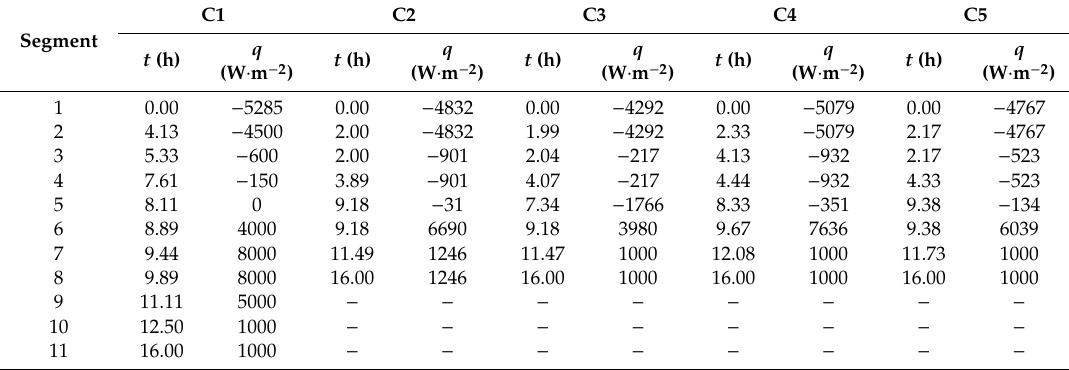
Table 5. Detailed description of the heating / cooling process.